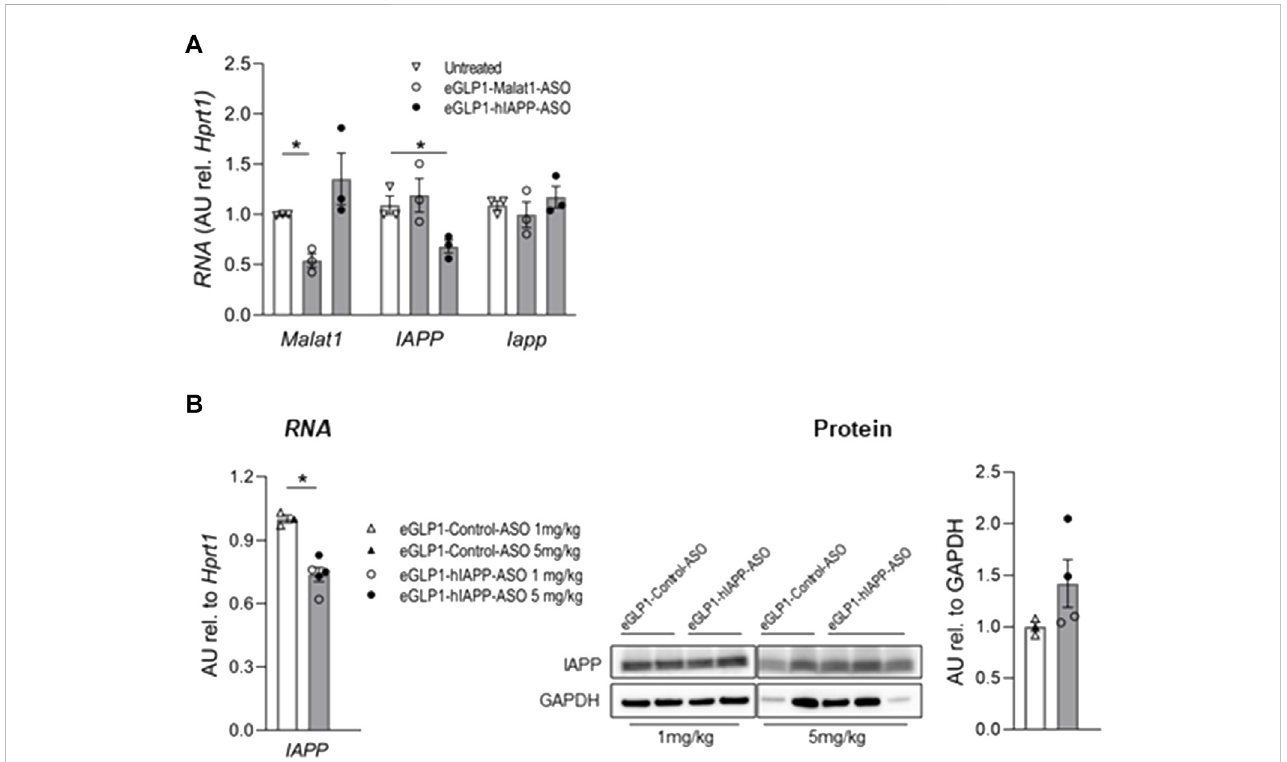
FIGURE 1 Evaluation ofeGLP1-hIAPP-ASOinmouse islets invitro and invivo . (A) eGLP1-hIAPP-ASO(500 nM) speci fi cally decreases expression hIAPP inhTGislets after invitro 24 htreatment; representativeexperimentperformedintriplicates;eGLP1-Malat1-ASOwasused aspositive control. (B) Short-termtreatment of hTG mice with eGLP1-hIAPP-ASO ( fi lled bars) resulted in the decrease in hIAPP RNA without effect on protein level of monomeric IAPP compared to mice treatedwitheGLP1-Control-ASO(eGLP1peptideconjugatedtoanASOwithascramblednucleotidesequence;openbars).Micereceivedeither1 mg/kg (open symbols) or 5 mg/kg ( fi lled symbols) of ASO on day 0 and 4, and islets were isolated on day 7. Only samples with strong GAPDH signal were included in the western blot quanti fi cation. Data is mean ± SEM; * - p < 0.05, two-tailed non-paired Student ’ s